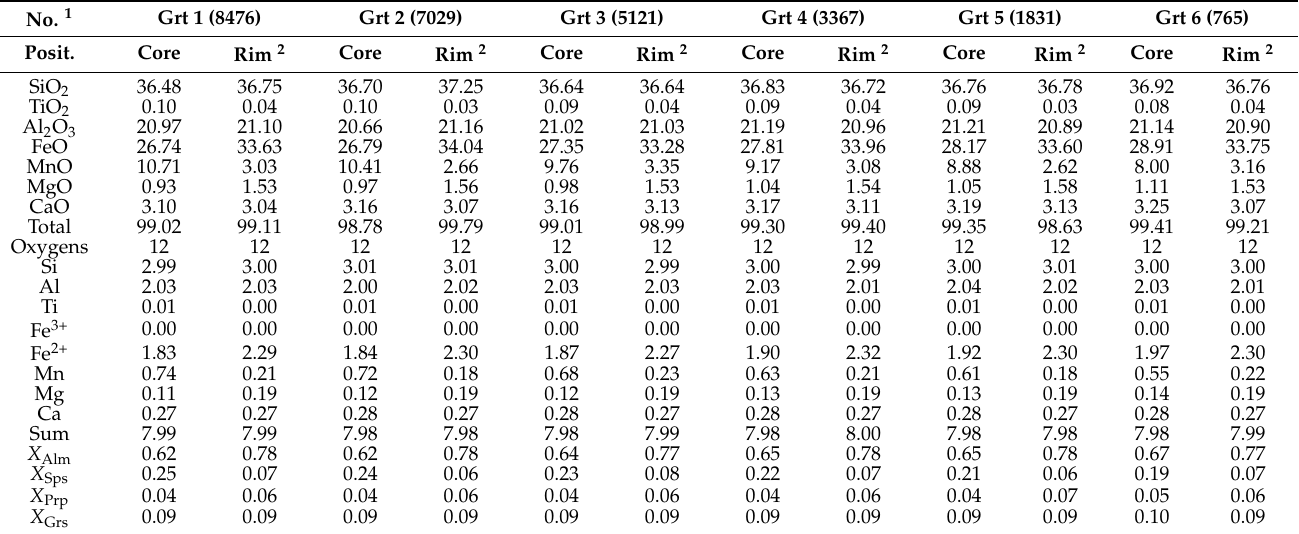
Table 2. Representative electron microprobe analyses for six garnet grains of the micaschist